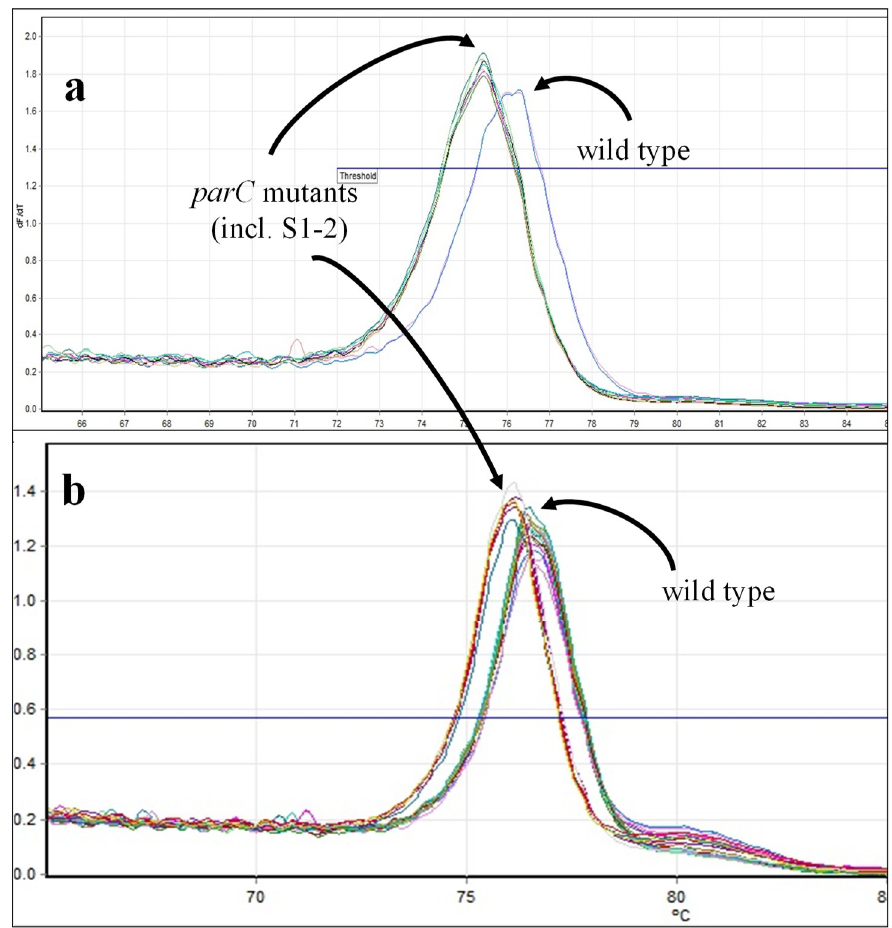
Figure 9. ParC melt curves for B. anthracis strains. ( a ) Melt curves for wild-type strains, Sterne and ∆ ANR, and gyrA -mutated ∆ ANR strains, S1-1, S1-2, S2-1, S2-2, S2-3, S3-1, S3-3, and S3-4. ( b ) Melt curves for the remainder of wild-type and gyrA -mutated ∆ ANR strains (see Table